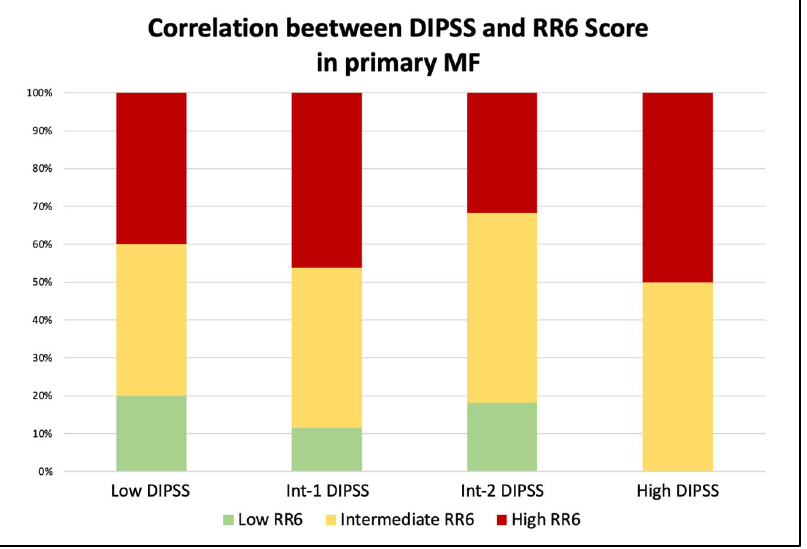
Figure 2. Correlation between RR6 and DIPSS risk classes in the context of primary myelofibrosis.